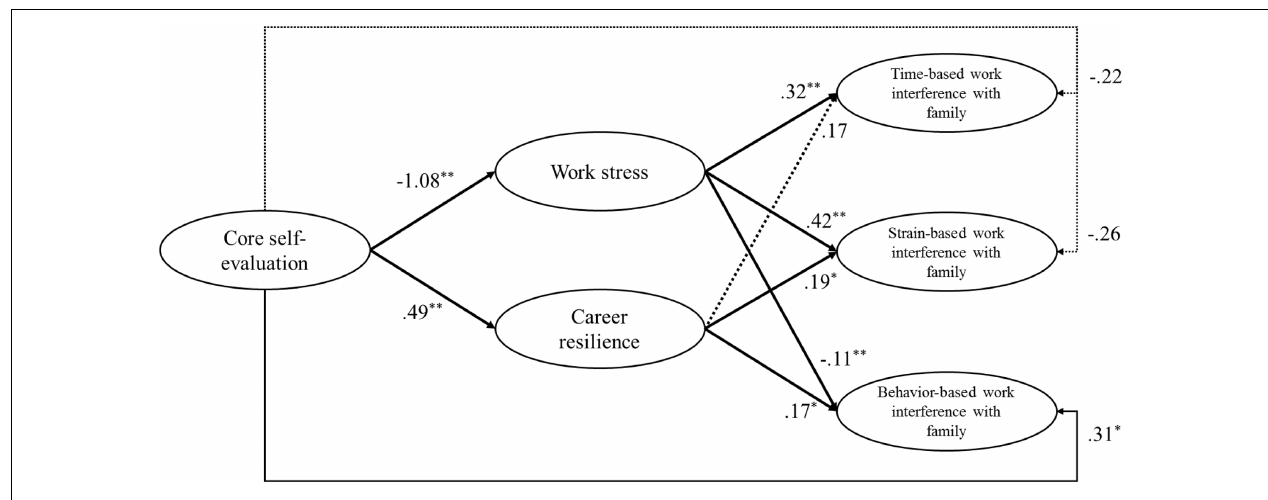
FIGURE 2 | Research path model. N = 561. ∗ p < 0.05; ∗∗ p < 0.01(two-tailed test).